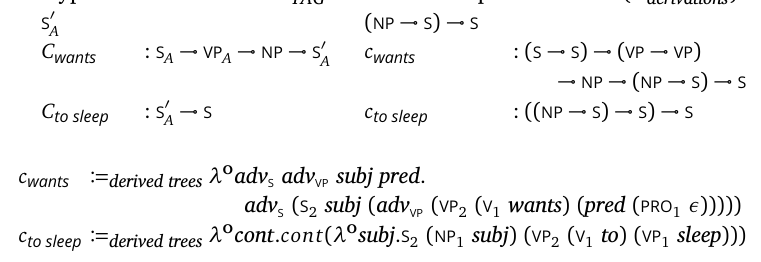
Table 14: Types and constants of (cid:6) TAG Their interpretations in (cid:3)((cid:6) derivations ) G TAG extension – control verbs